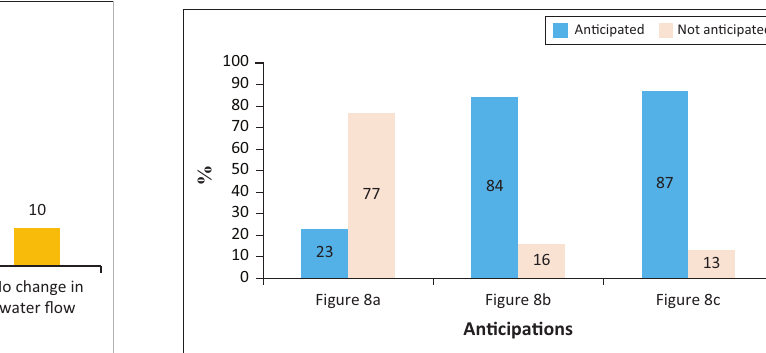
FIGURE 9: The anticipated and least anticipated picture of Victoria Falls ( n =